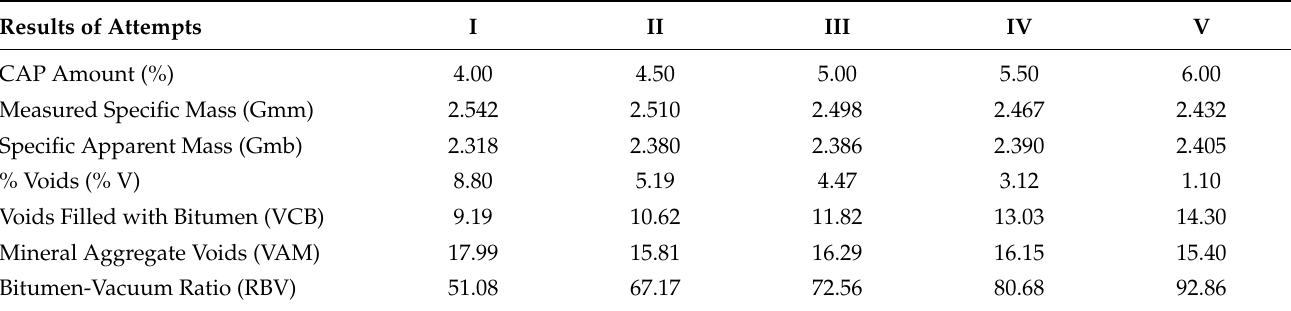
Marshall dosing parameters obtained for mixture M2 (with ash) and results of mechanical